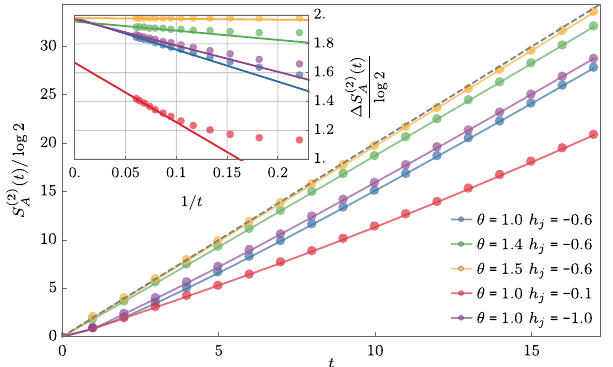
FIG. 11. Time evolution of different R´enyi entropies in a kicked Ising system with longitudinal magnetic field h ¼ − 0 . 6 in the thermodynamic limit. The initial state is of the form (12) with θ ¼ ϕ ¼ 1 . The colored lines correspond to Renyi indices n ¼ 1 , 2, 3, 4 and are determined numerically evaluating Eq. (98), while the gray dashed line reports, for comparison, the result from 2 Þ ð t Þ separating states. The inset shows the instantaneous slope A Δ S ð n Þ ð t Þ [cf. Eq. (100)] as a function of 1 =t . The points are A computed by evaluating Eq. (98), while the lines are linear extrapolations from the last two data